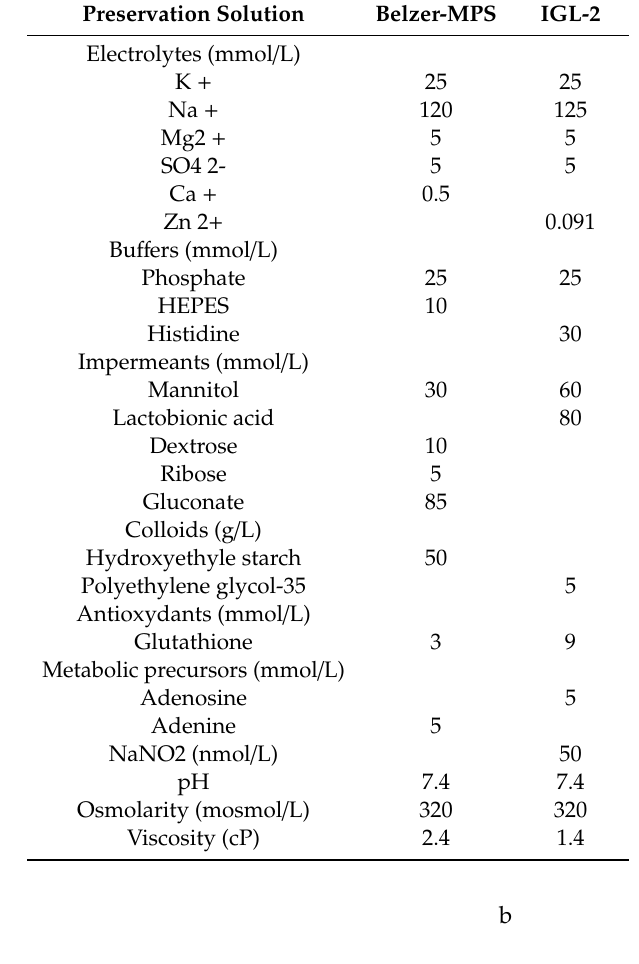
Table 2. Composition of IGL2 and Belzer MPS solutions.